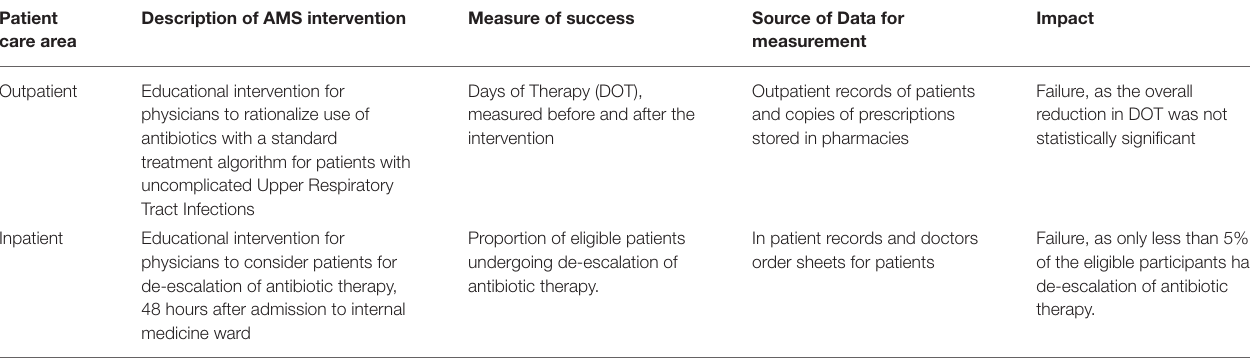
TABLE 2 | AMS interventions implemented in the hospitals.